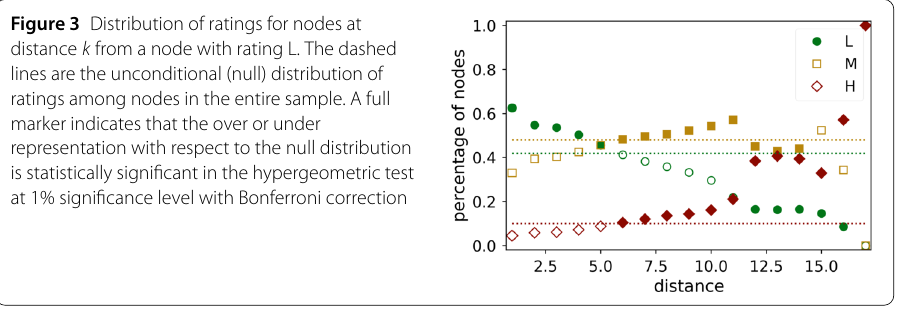
Figure 3 Distribution of ratings for nodes at distance k from a node with rating L. The dashed lines are the unconditional (null) distribution of ratings among nodes in the entire sample. A full marker indicates that the over or under representation with respect to the null distribution is statistically significant in the hypergeometric test at 1% significance level with Bonferroni